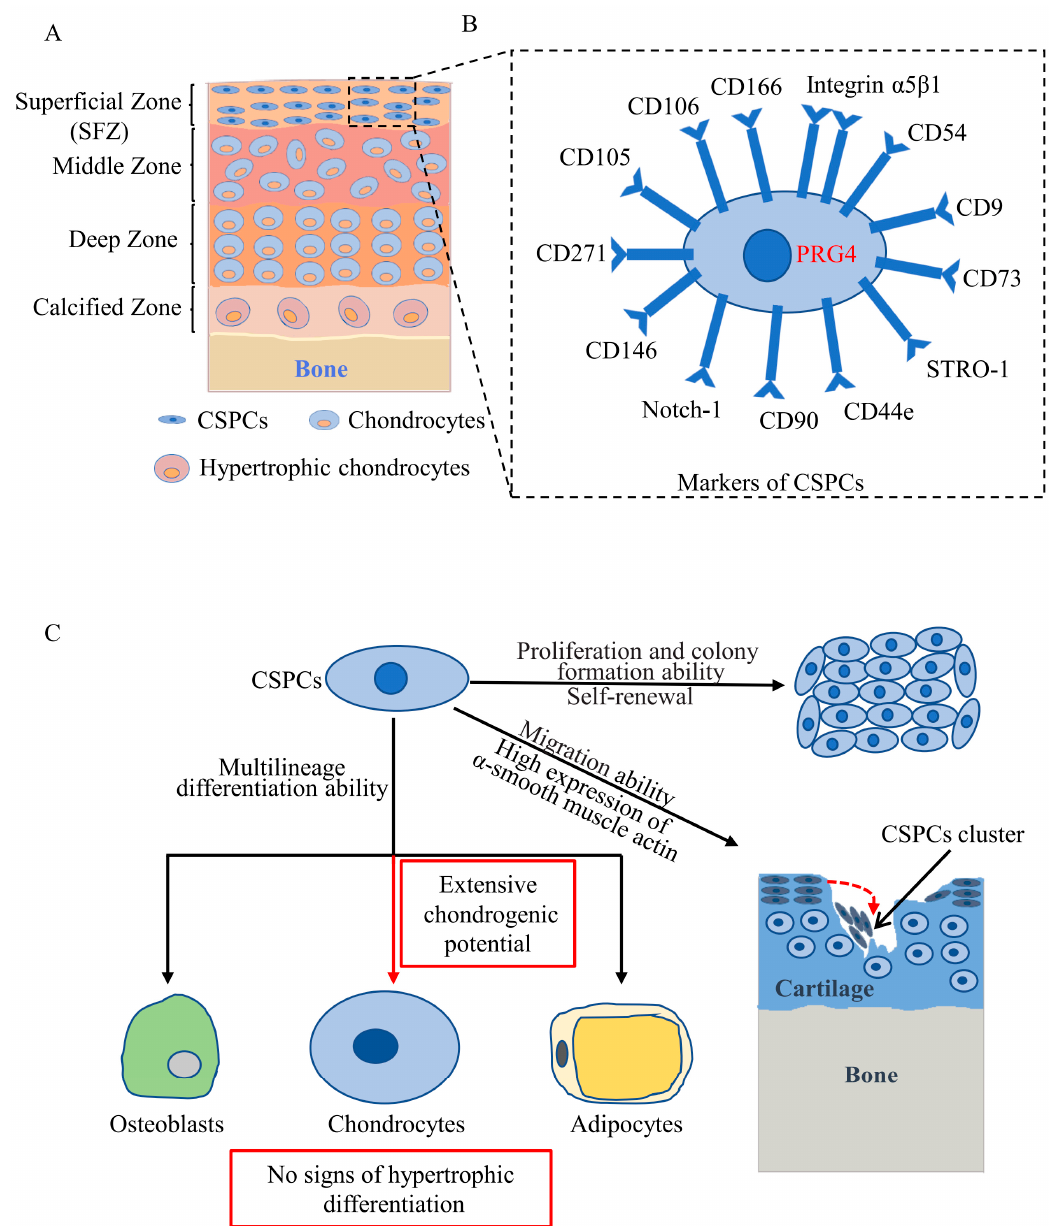
Figure 1. Zonal architecture of articular cartilage, including the distribution, markers and cytological features of CSPCs. ( A ) Normal adult cartilage consists of superficial, middle, deep, and calcified zones, and CSPCs reside in the superficial zone. ( B ) CSPCs express various MSC-related surface markers individually or in combination, and PRG4 is a specific marker of CSPCs in mice. ( C ) Properties of CSPCs: proliferative potential, colony-formation ability, multilineage differentiation ability and migration ability.